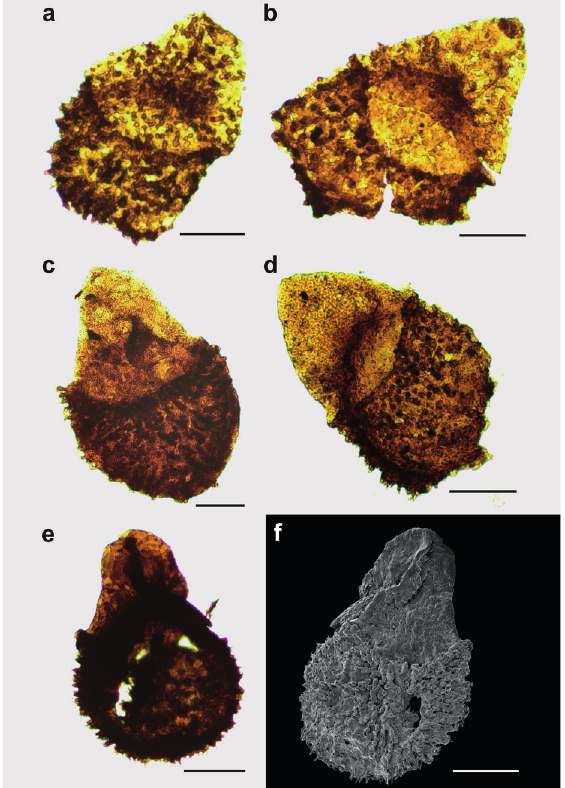
Figure 2 - Lagenoisporites magnus megaspores compressed laterally where the main body, the gula and the curvaturae perfectae can be distinguished. a-e . Megaspores observed with light microscope (LM). a: Specimen CICYttP-M 139. b: Specimen CICYttP-M 140. c: Specimen CICYttP-M 144. d: Specimen CICYttP-M 151. e: Specimen CICYttP-M 162. f. Megaspores observed with scanning electron microscope (SEM). Specimen CICYTTP-M 162. Scale bar: 100 μm.